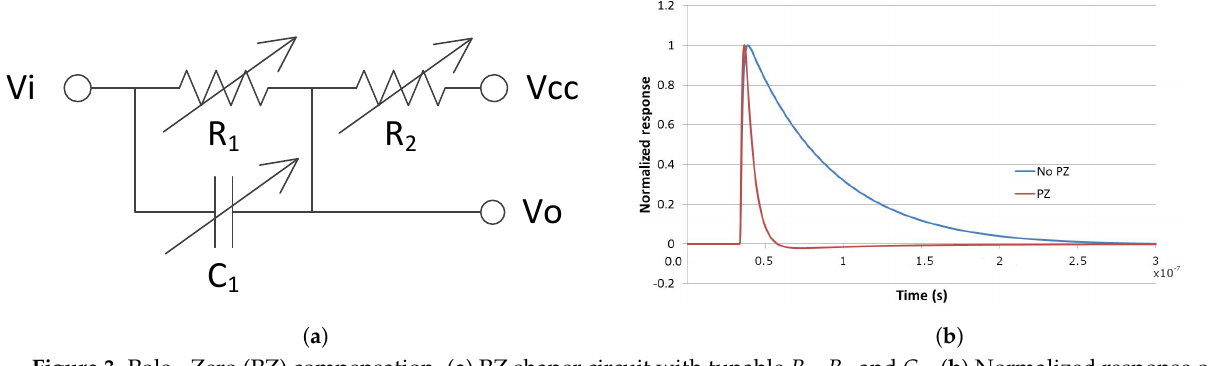
Figure 3. Pole − Zero (PZ) compensation. ( a ) PZ shaper circuit with tunable R 1 , R 2 and C 1 . ( b ) Normalized response of a single photon using a Hamamatsu SiPM S13350 − 6050CS with and without PZ cancellation. In this example, the peak signal after the PZ shaper was attenuated an ≈